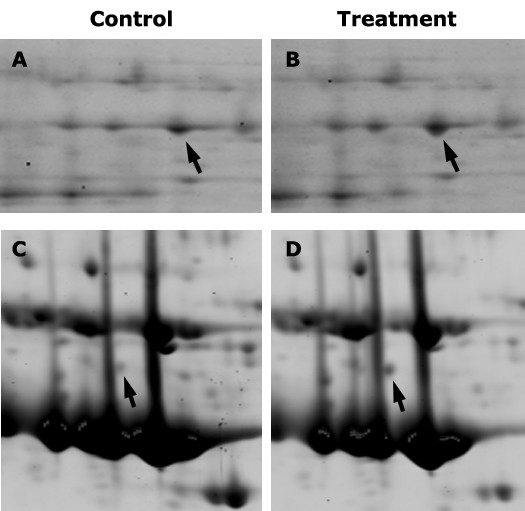
Portions of 2-D gels showing spots (arrows) that were differentially abundant between xylem saps of control (A, C) and elicitor (B) or B. japonicum-treated (D) soybean plants. Arrows in A & B indicate spot no. 26 (putative subtilisin) and arrows in C & D indicate spot no. 15 (XET).